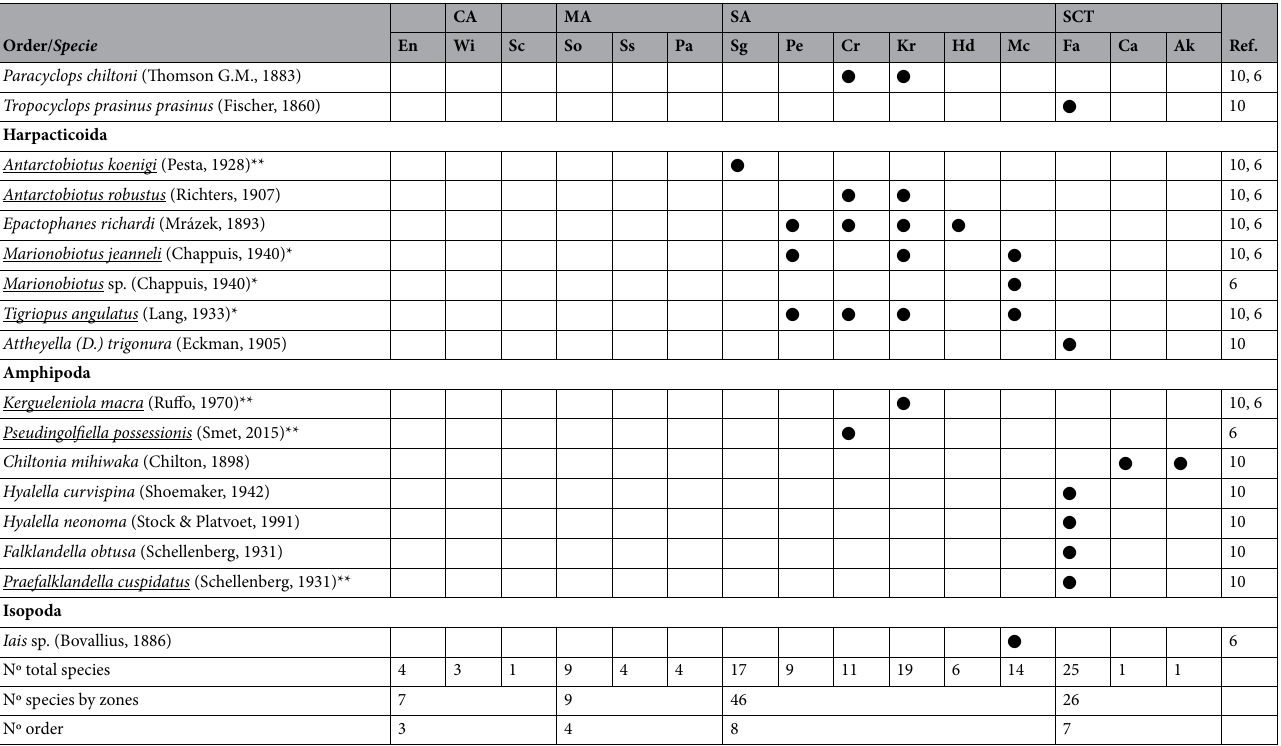
Table 1. Presence/absence matrix of crustacean taxa in lakes of each study region based on Pugh et al. 2002 10 and Dartnall et al. 2017 6 . Provinces: CA, Continental Antarctic; MA, Maritime Antarctic; SA, Subantarctic islands; SCT, Southern Cool Temperate. Regions: En, Enderby; Wi, Wilkes; Sc, Scott; So, South Orkney Islands; Ss South Shetland Islands; Pa, Antarctic Peninsula; Sg, South Georgia; Pe, Prince Edward Island; Cr, Iles Crozet; Kr, Iles Kerguelen; Hd, Heard Island; Mc, Macquarie Island; Fa, Falkland/Malvinas Islands; Ca, Campbell Island; Ak, Auckland Island. Underlined species: Endemic from one biogeographic province; *Endemic from two or more biogeographic provinces; **Endemic from one region within a